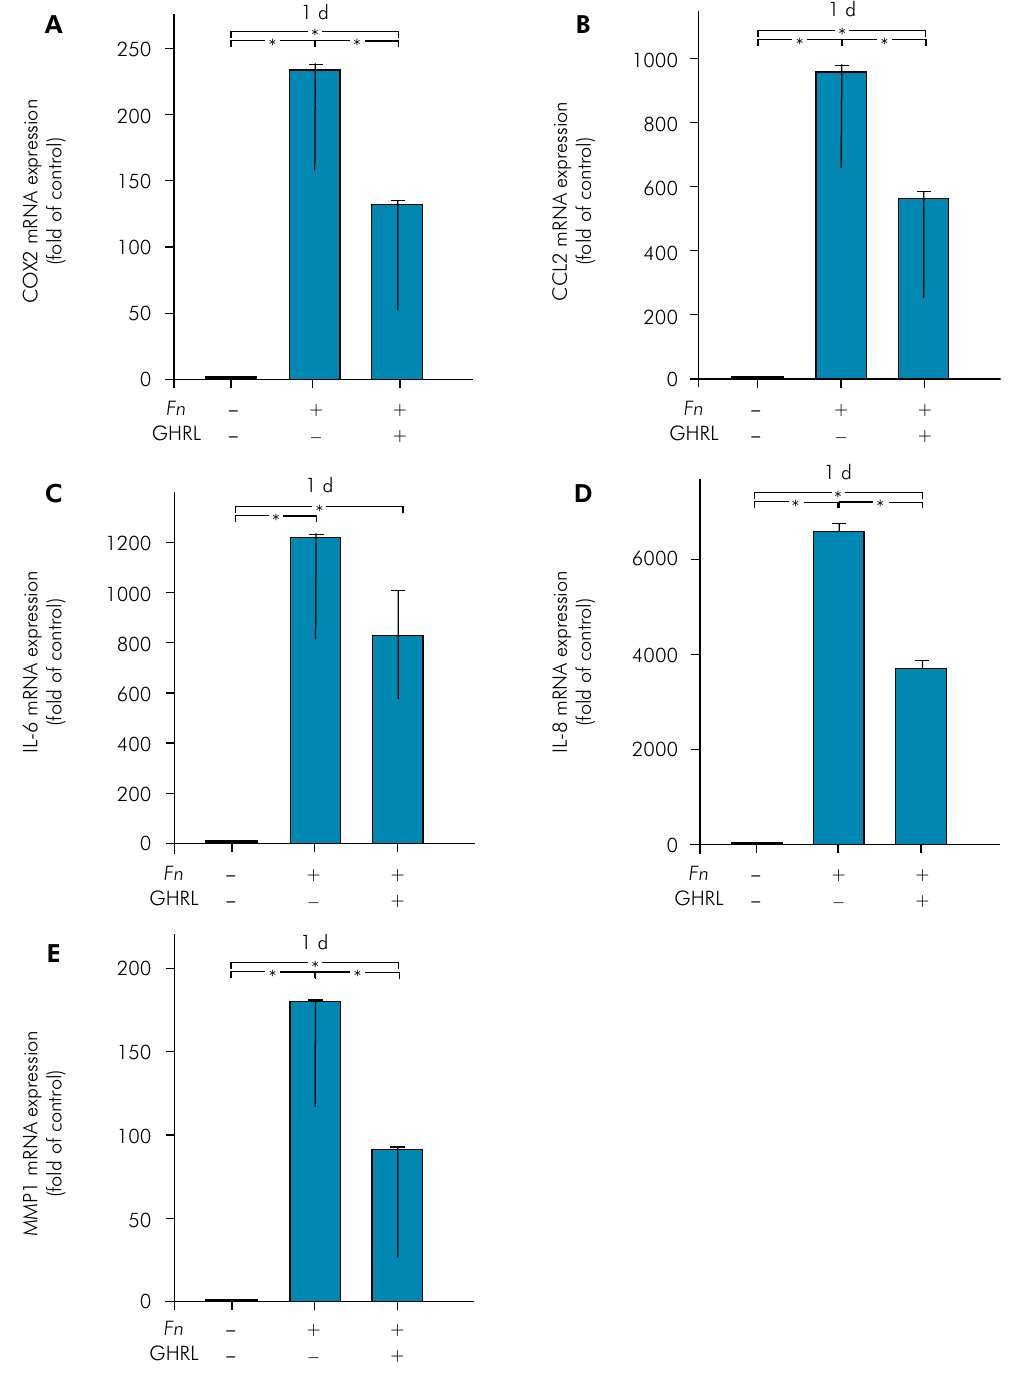
Figure 3. Expression of COX2 (A), CCL2 (B), IL-6 (C), IL-8 (D) and MMP1 (E) in response to F. nucleatum ( Fn ; OD: 0.1) in the presence and absence of GHRL (20 nM) at 1 d. Unstimulated cells served as control. Mean ± SEM ( n = 3).